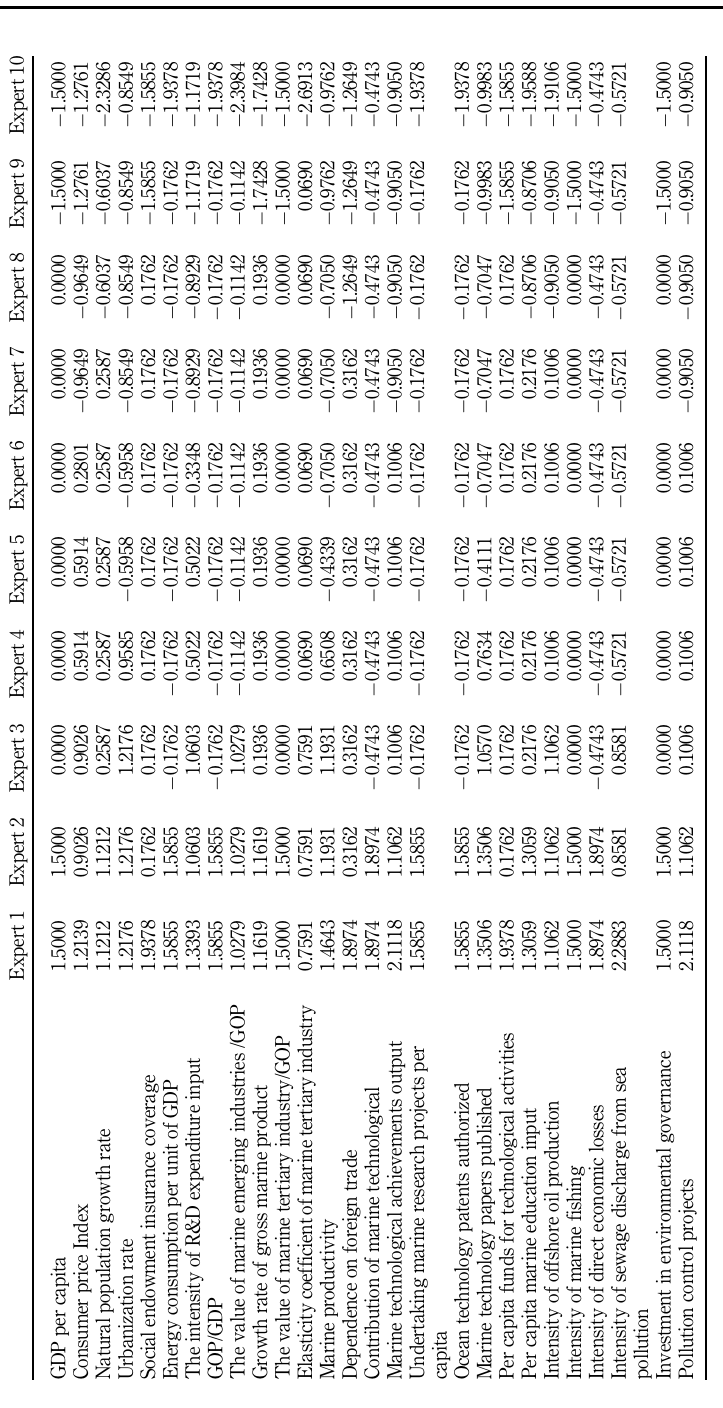
Table 1. Validity test of